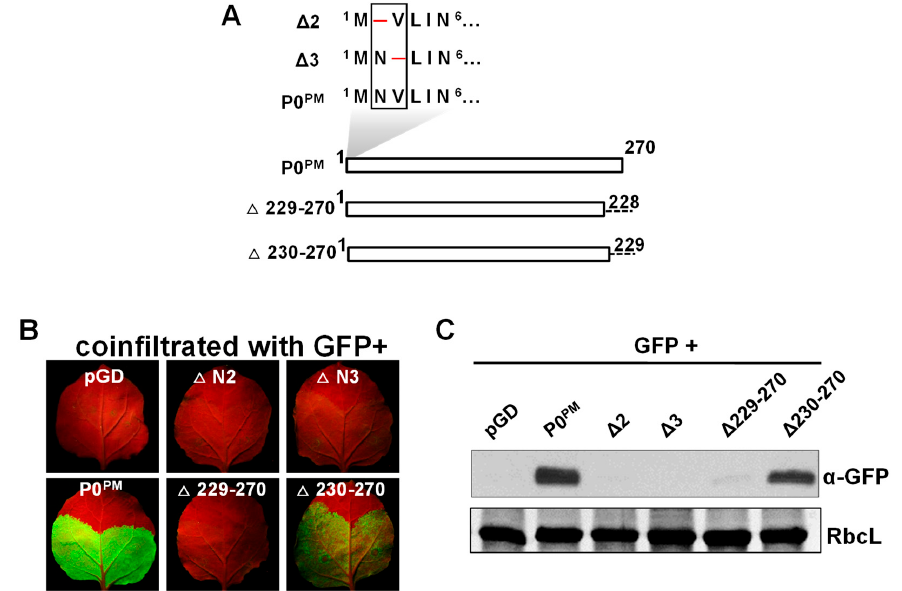
Figure 2. Requirement of N- and C-terminal amino acids of P0 PM for suppressor activity. ( A ) Schematic representation of amino acids deleted ( ─ ) in the N-terminus of P0 PM (upper panel) and C-terminal truncation mutants (lower panel). Numbers correspond to the amino acid positions within the P0 PM sequence. ( B ) Agroinfiltration of N. benthamiana leaves with GFP plus empty vector pGD, P0 PM mutants or P0 PM , respectively. The empty vector pGD was used as negative control. Photographs were taken under long-wavelength UV light at 5 dpi. ( C ) GFP proteins from infiltrated leaves were detected by Western blotting at 5 dpi. GFP was detected with GFP polyclonal antiserum. RbcL is the Rubisco large subunit.